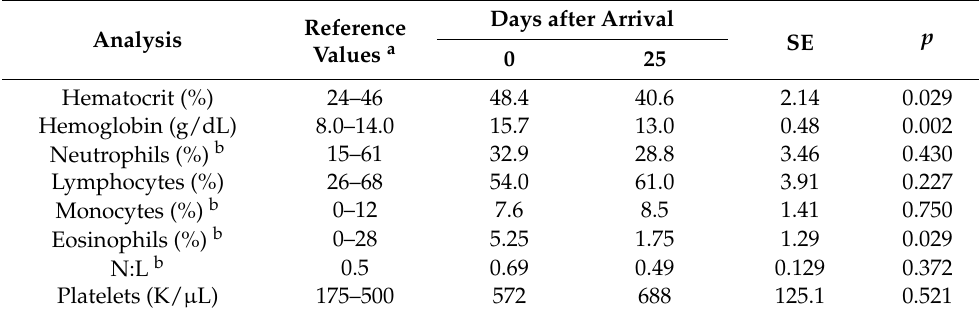
Table 3. Complete blood count values of heifers at 0 and 25 days post-arrival.